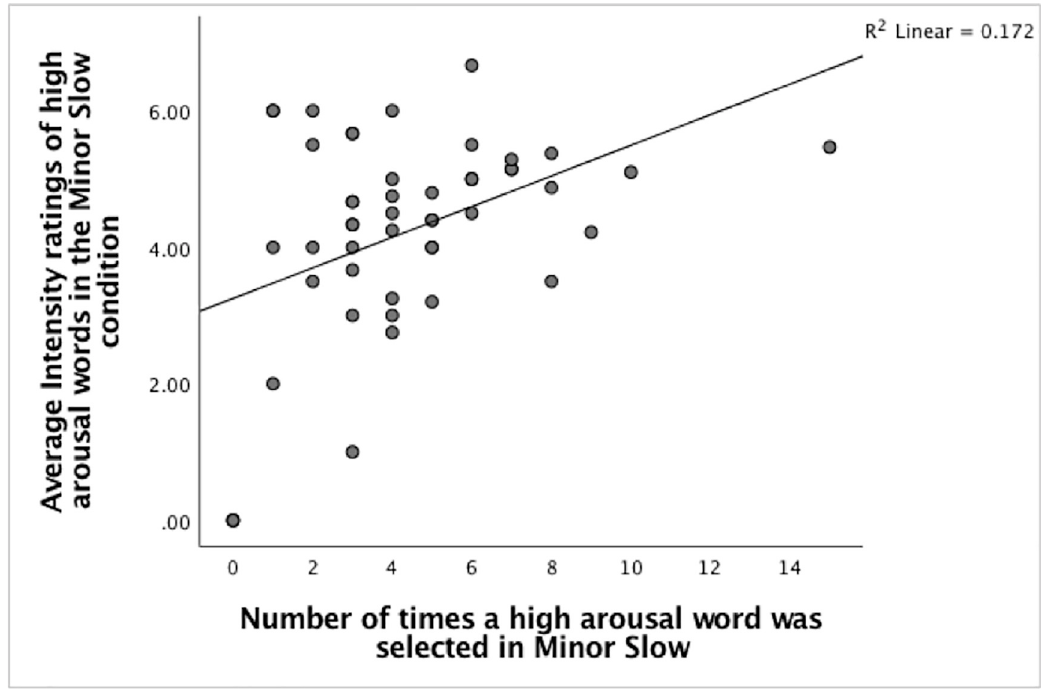
Fig 15. The relationship between the number of high arousal words selected and the rated intensities in the Minor-Slow condition.